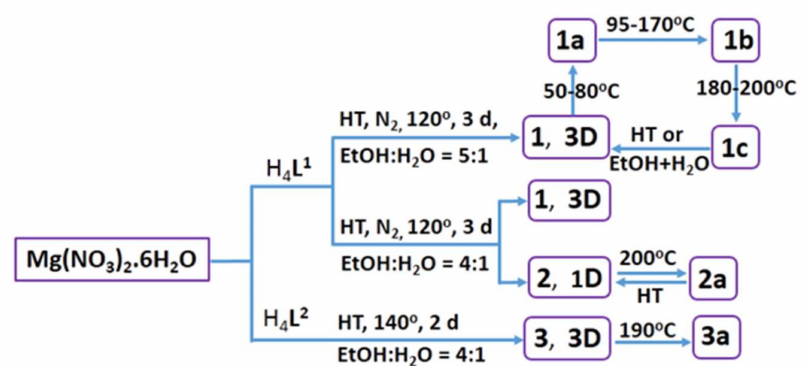
Scheme 2. Overall sketch for complexes 1 – 3